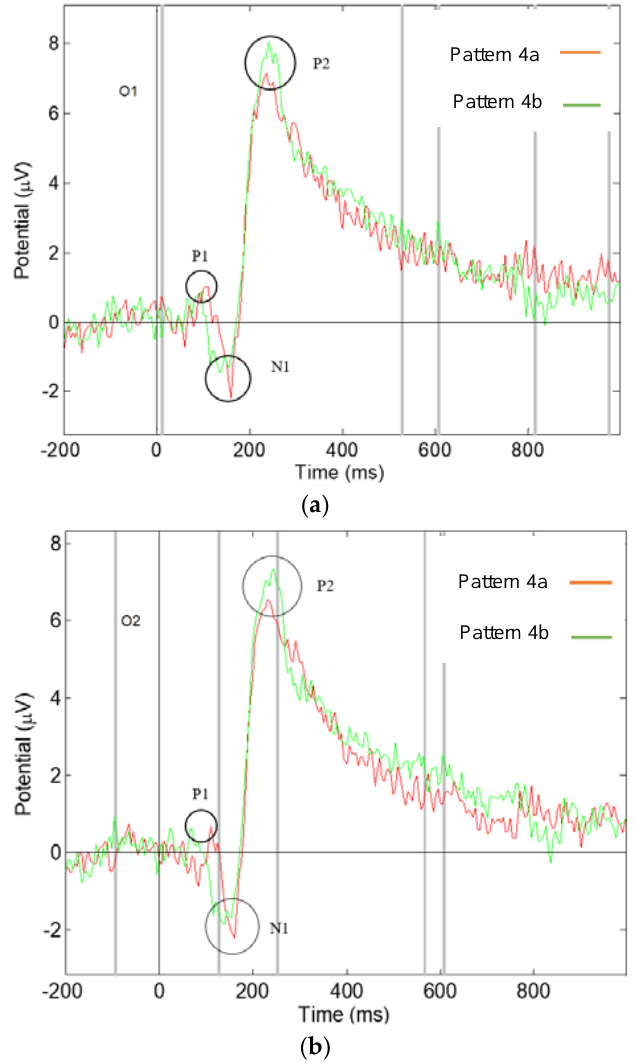
Figure 12. Grand average ERP responding to Pattern 4a,b, the grey lines show the significant di ff erence with p -value < 0.05: ( a ) measured at O1 electrode channel; ( b ) measured at O2 electrode